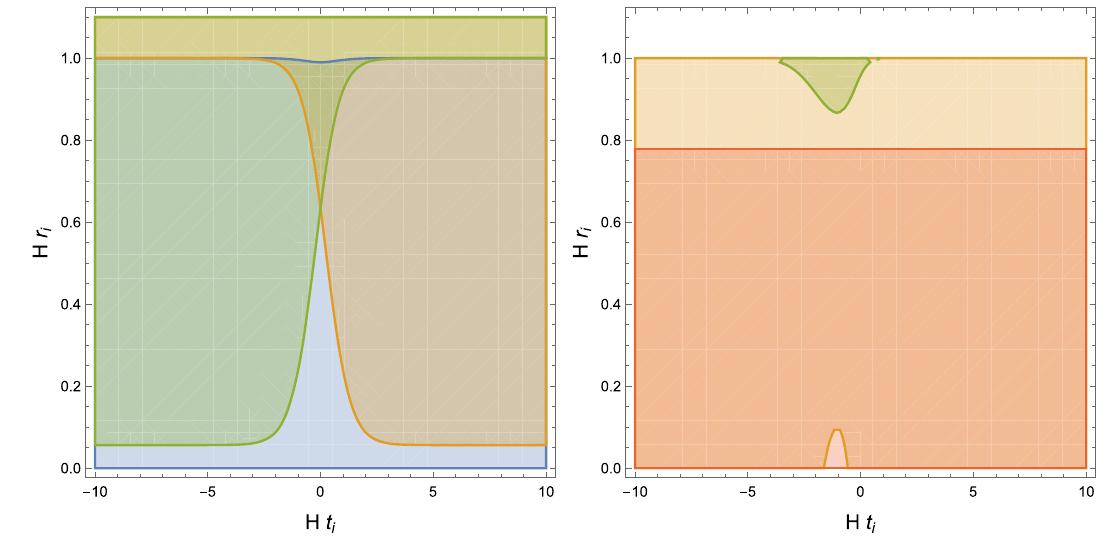
Fig. 9 Regions satisfying three conditions for cG ( 3 ) H /( 6 π) = 5 × 0 . 09 and G ( 3 ) H = (cid:10) UV H = 0 . 1. (Left): Constant central charge ( dc / dt i = 0) case. Regions satisfying condition 1, ∂ U S gen ( I ) ≥ 0 in condition 2, and ∂ V S gen ( I ) ≤ 0 in condition 2 are colored in blue, orange, and green respectively. The region allowed by condition 3 is not drawn as it is trivially satisfied in the whole region Hr i < 1. The region allowedbyalltheconditionscanbefoundfor H | t i | < 2and Hr i > 0 . 6. (Right): Evolving central charge case with ( dc / dt i )/( cH ) = 0 . 5.